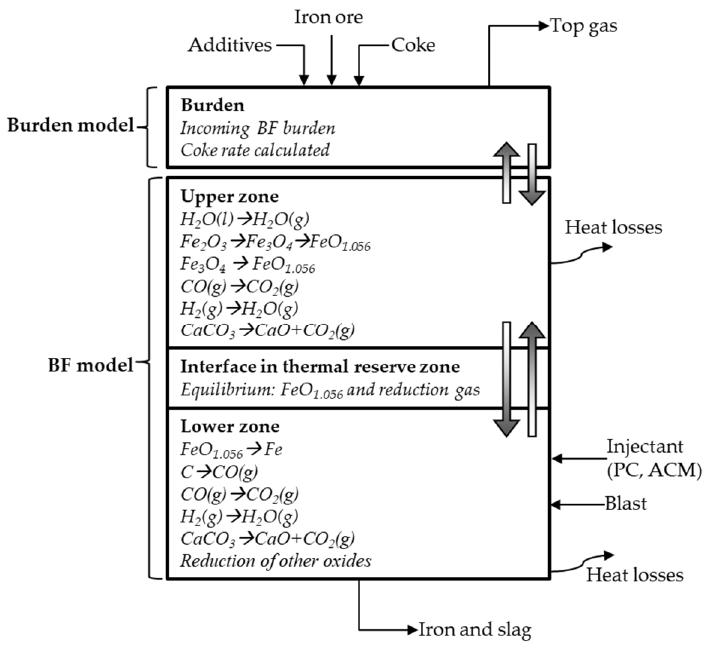
Figure 1. Schematic representation of blast furnace (BF) as described by MASMOD [18]. Interface between Upper and Lower Zones-TRZ-eq